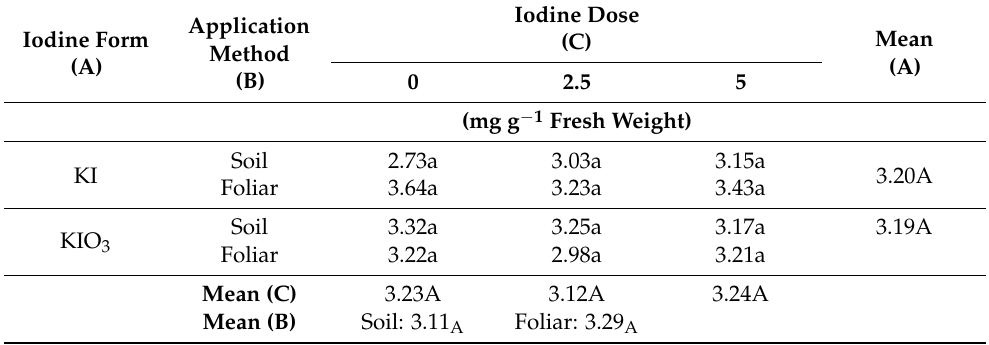
Table 4. C arotenoids content in rye plants depending on I dose, form, and method of application.